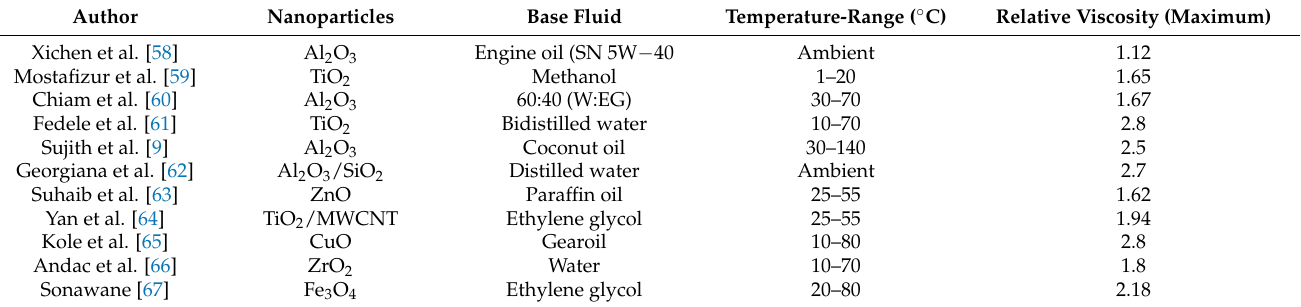
Table 3. Relative viscosity of various metal oxide based nanofluids at several different